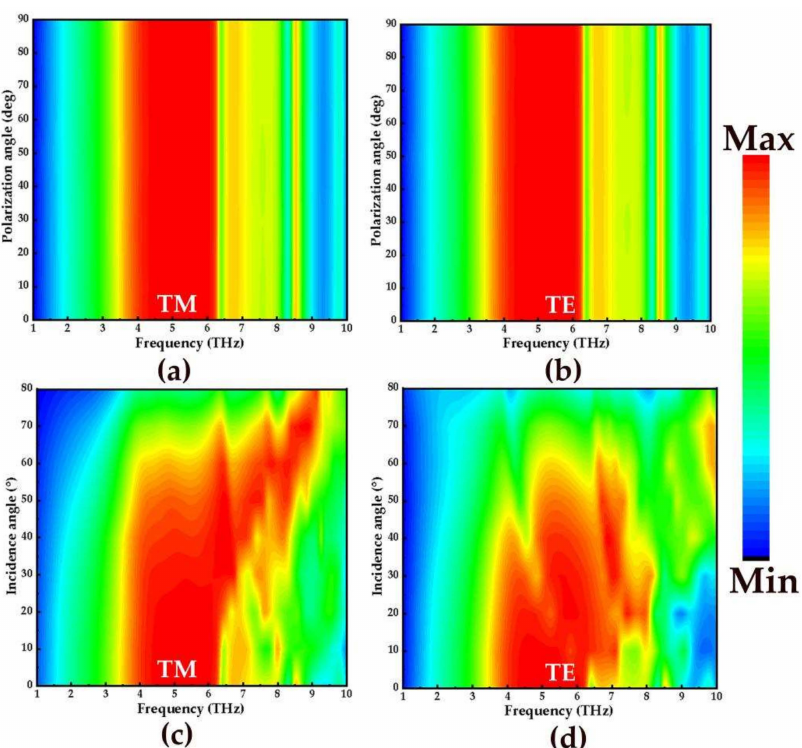
Figure 7. The absorption spectra of broadband absorbers in TM and TE mode: ( a , b ) different polarization angles; ( c , d ) different incident angles.